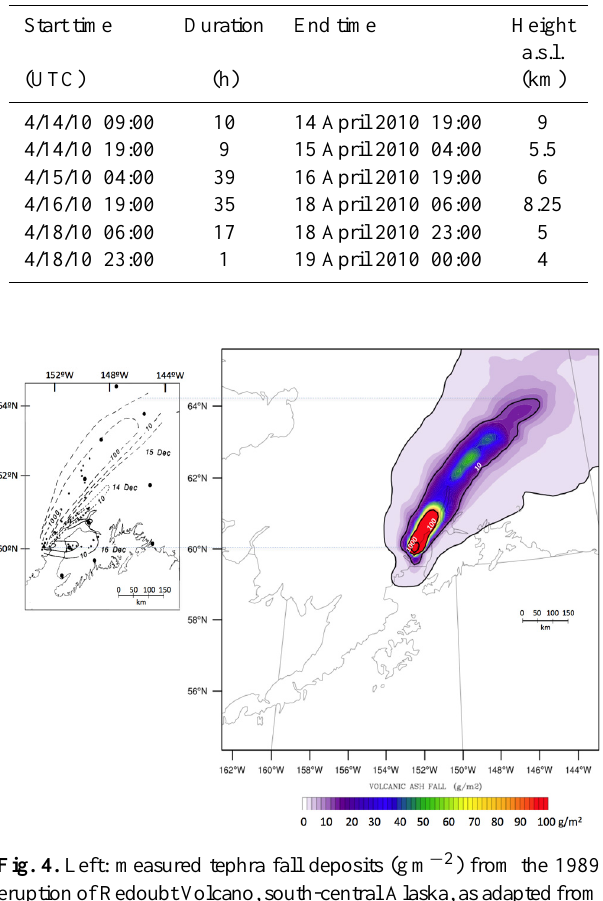
Fig. 4. Left: measured tephra fall deposits (gm − 2 ) from the 1989 eruption of Redoubt Volcano, south-central Alaska, as adapted from Scott and McGimsey (1994). The dotted and dashed contour lines (2, 10, 100, and 1000gm − 2 ) delineate the derived isomass from 14 and 15 December 1989; the measurement locations are indicated with small dots (large dots are geographic reference points). Right: WRF-Chem modelled ash-fall produced by the 2 main eruptions from 14 December using the same isomass contour